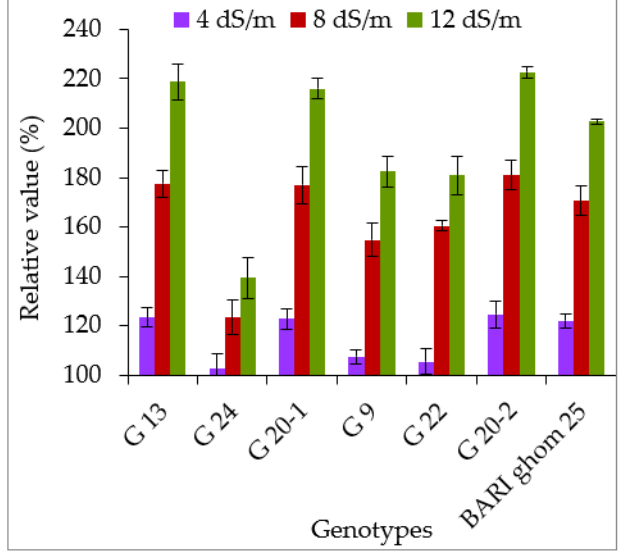
Figure 12. Relative value of glycine-betaine content in leaf of wheat genotypes under various salinity levels. The vertical bar indicates average data of five independent replicates ( n = 5). Error bars represent standard error.